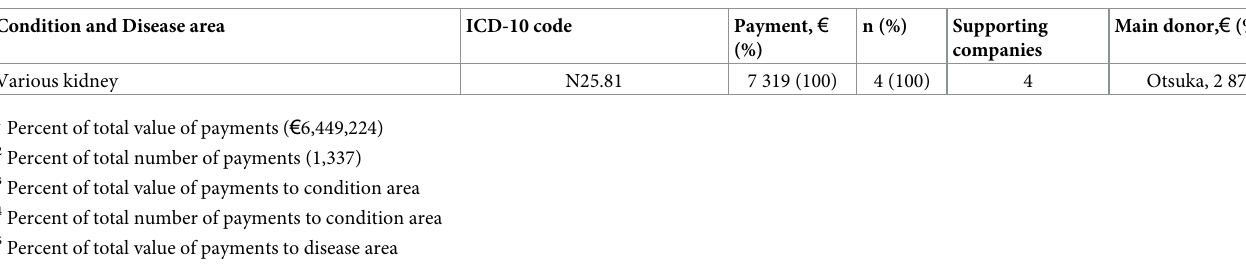
Table 6. Drug commercialisation and patient organisation funding in the ten most funded disease areas for the top ten drug industry donors in Sweden (2014–18). Breast can. HIV Blood can. Gener. can. Diab. Prost. can. Hemo-ph. Rheu-ma. Enter., Col.,